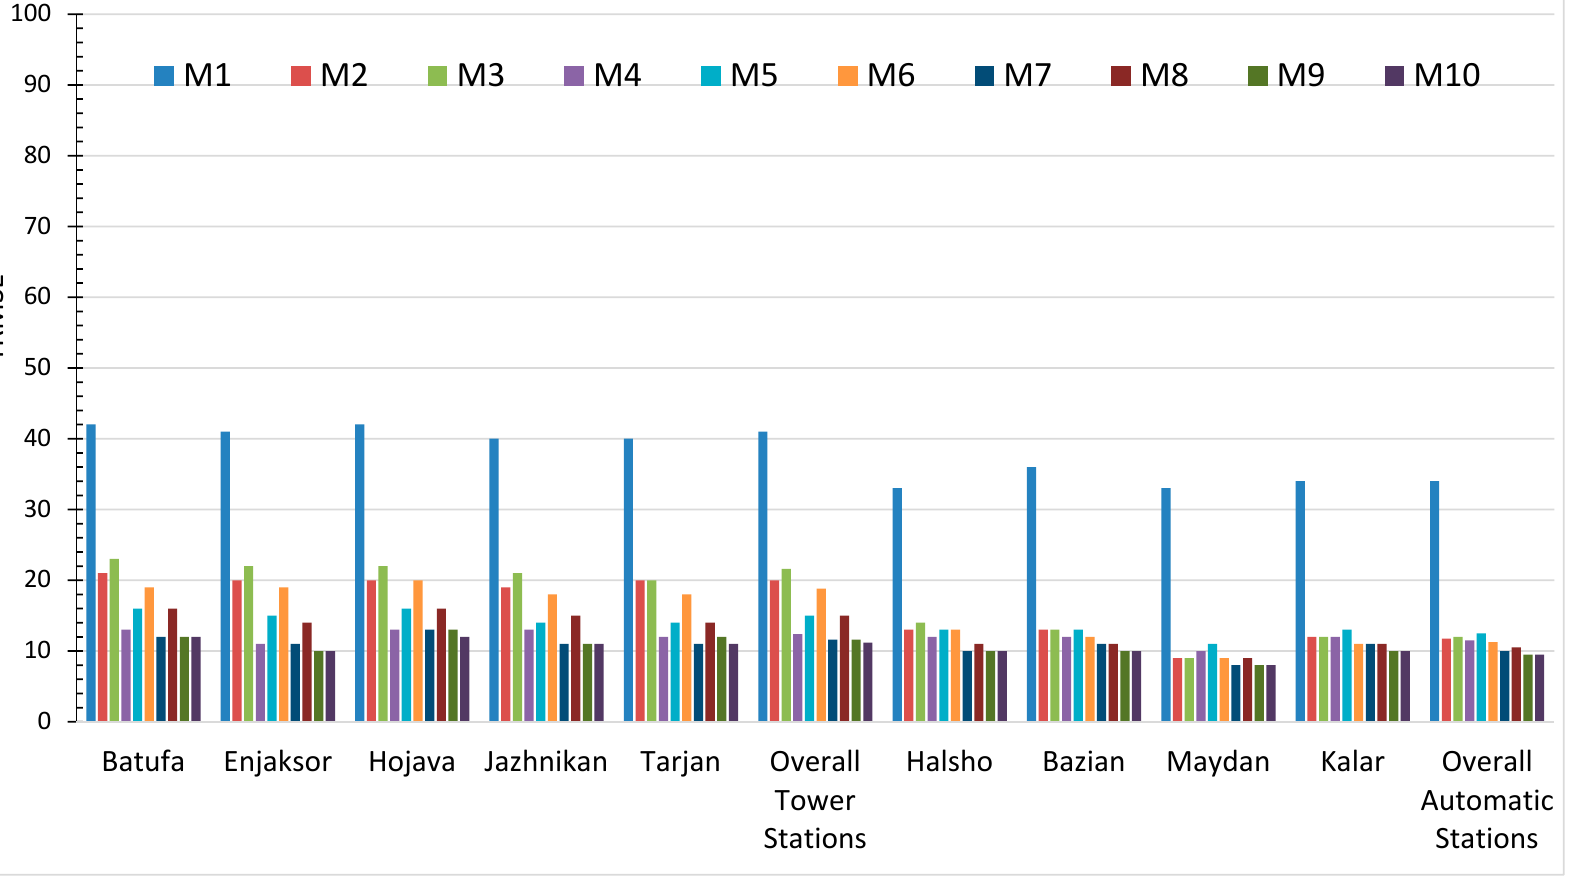
Figure A2. As in Figure A1, but for rRMSE.